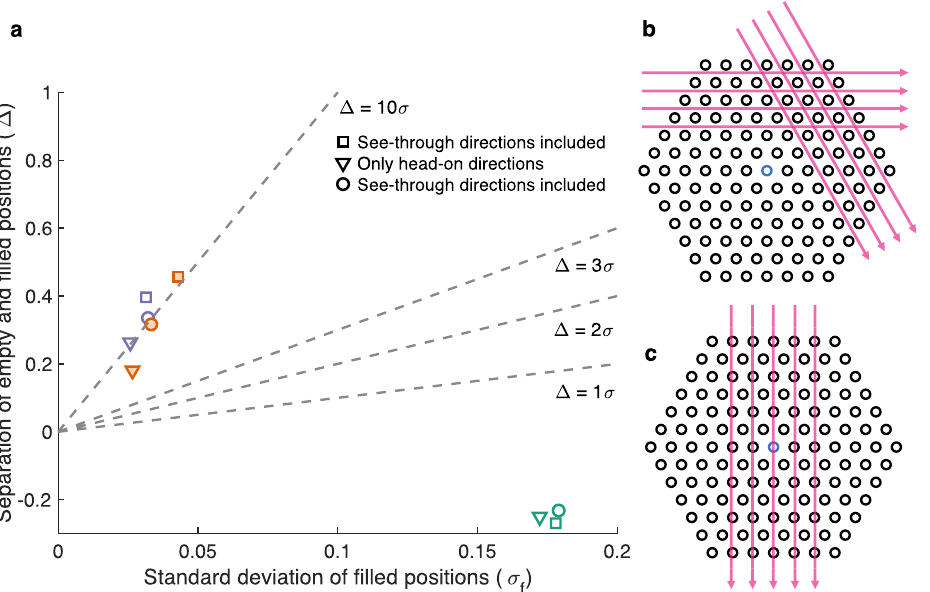
Figure 8. ( a ) Image quality index plot for images of VVER-440 assemblies from Loviisa 2020 with reconstruction directions that include or do not include the see-through directions. Images with see-through directions included are marked with squares and circles. Images where only head-on directions are used in the set are marked with triangles. The three colors denote three different assemblies. ( b ) The so-called “see-through directions” for a VVER-440 assembly. Two of the six see-through directions from which the detectors see right between the rod rows are marked with arrows. ( c ) A “head-on direction”, where the line of sight is always blocked by fuel rods is marked with arrows.